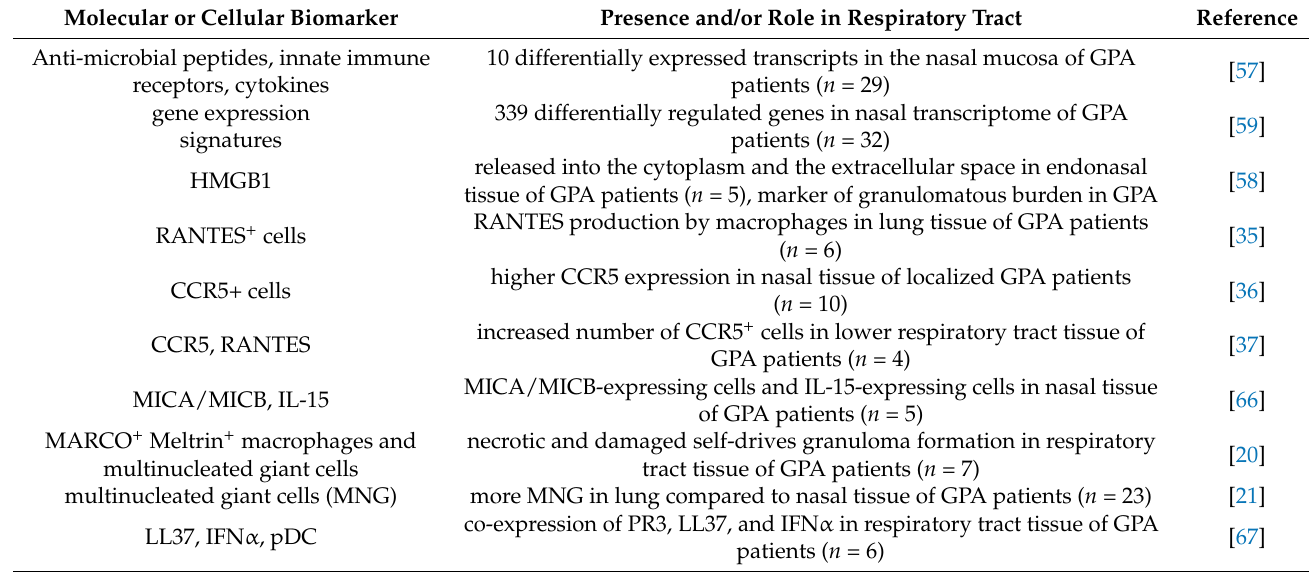
Table 1. Overview about molecular and/or cellular markers of the innate and adaptive immune response suggested to participate in the granulomatous inflammation and to support autoimmune and destructive mechanisms in the upper and lower respiratory tract of GPA